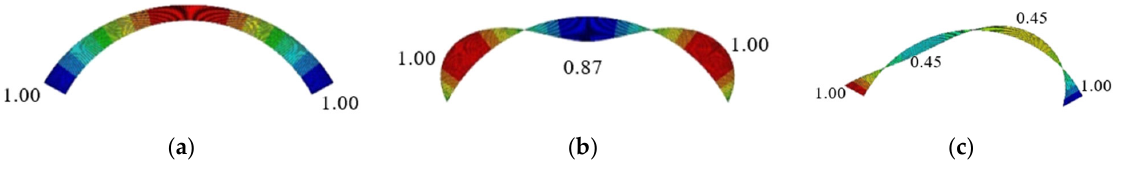
= 0.3): ( a ) axial force; ( b )